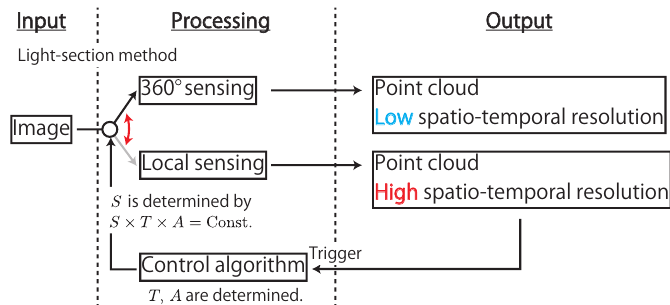
Figure 3. Flowchart of AdjustSense.